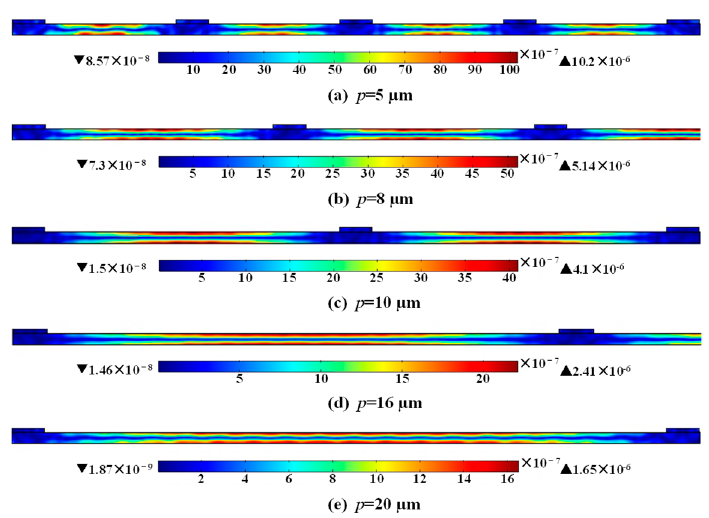
Figure 10. The simulated displacement distribution at resonance as ( a ) p = 5 µm, ( b ) p = 8 µm, ( c ) p = 10 µm, ( d ) p = 16 µm and ( e ) p = 20 µm, while the width of electrode is maintained at 1 µm.